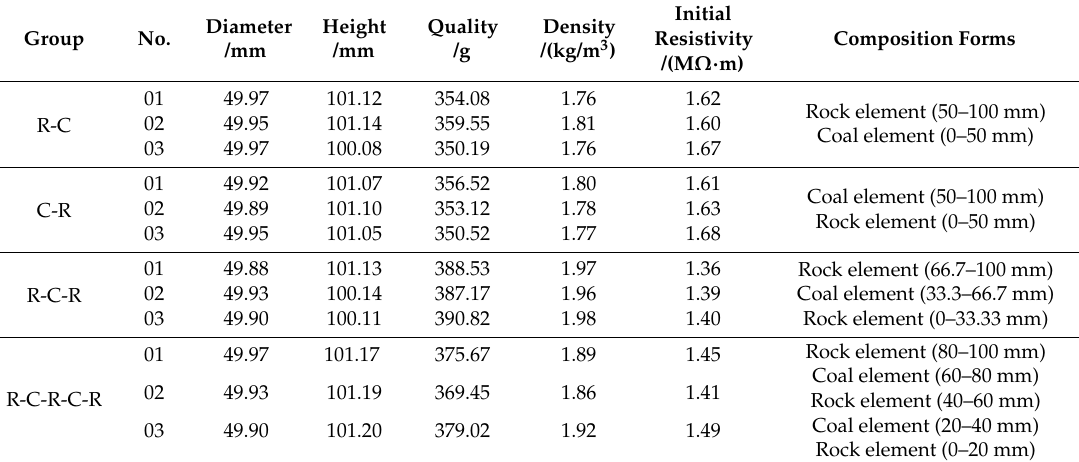
Table 2. Physical parameters and composition forms of sandwiched coal-rock